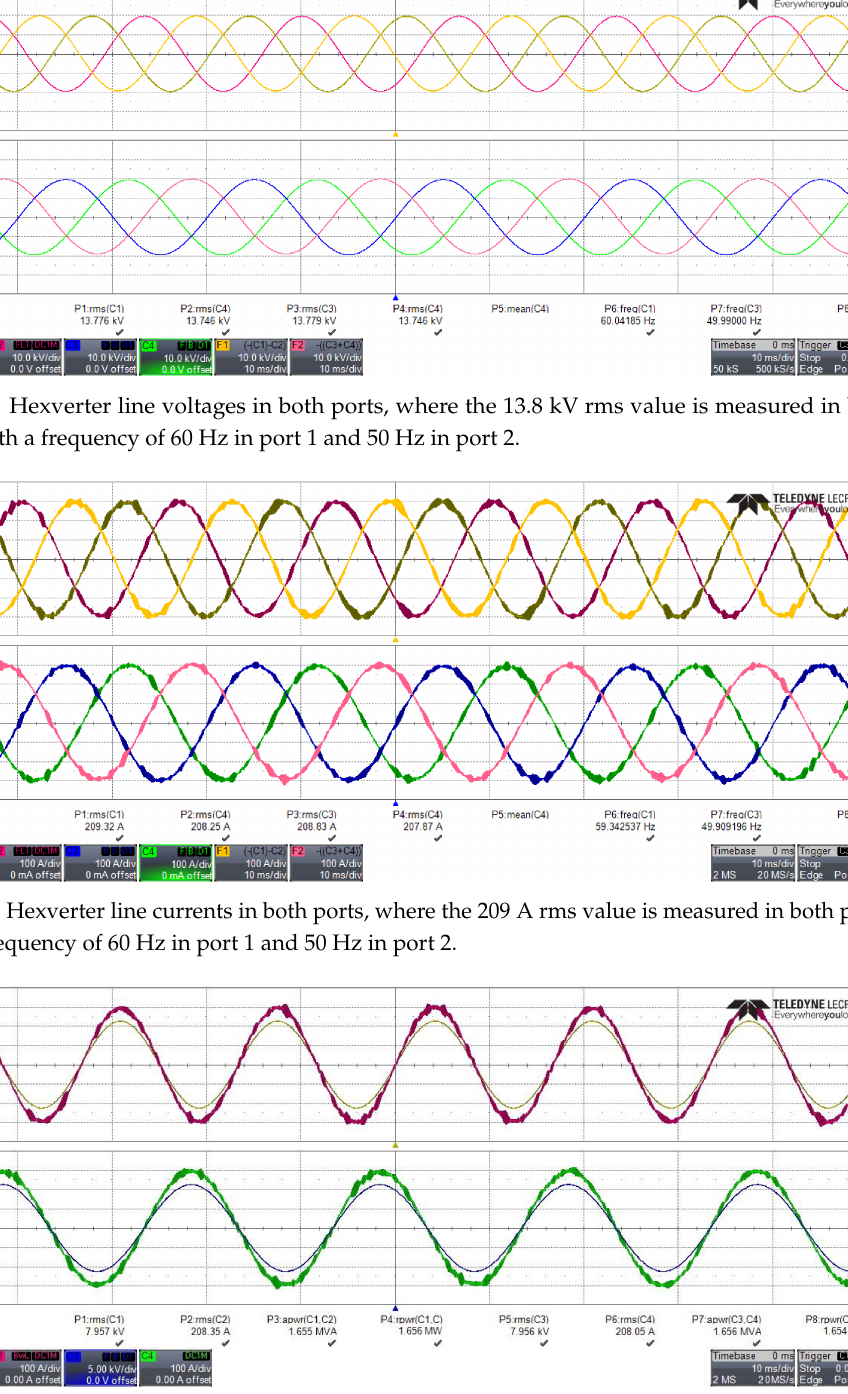
Figure 9. Converter operation with 5 MW power: phase voltage and line current in phase A port 1 and phase R port 2, showing the apparent and active power per phase in each